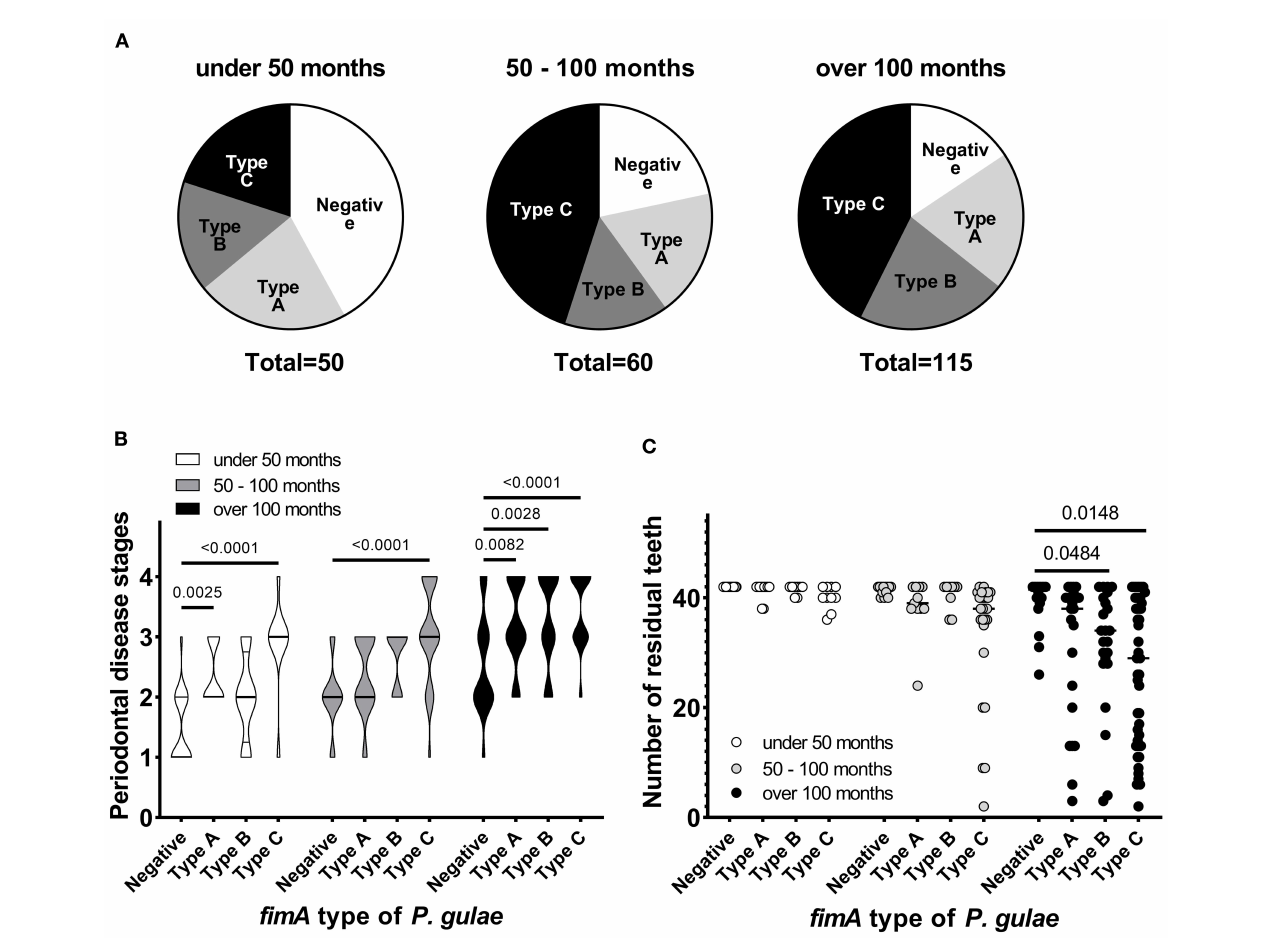
FIGURE1 Contribution of fimA type of Porphyromonas gulae to periodontal disease. (A) Porphyromonas gulae carriage and associated genotype. (B) Association between periodontal disease stage and fimA type of P. gulae in each age group (Dunnett’s multiple comparison test vs. the P. gulae -negative group). (C) Association between fimA type of P. gulae and the number of permanent teeth in each age group (a logistic regression analysis between full dentition and < 42 teeth in 50–100 and > 100 months age